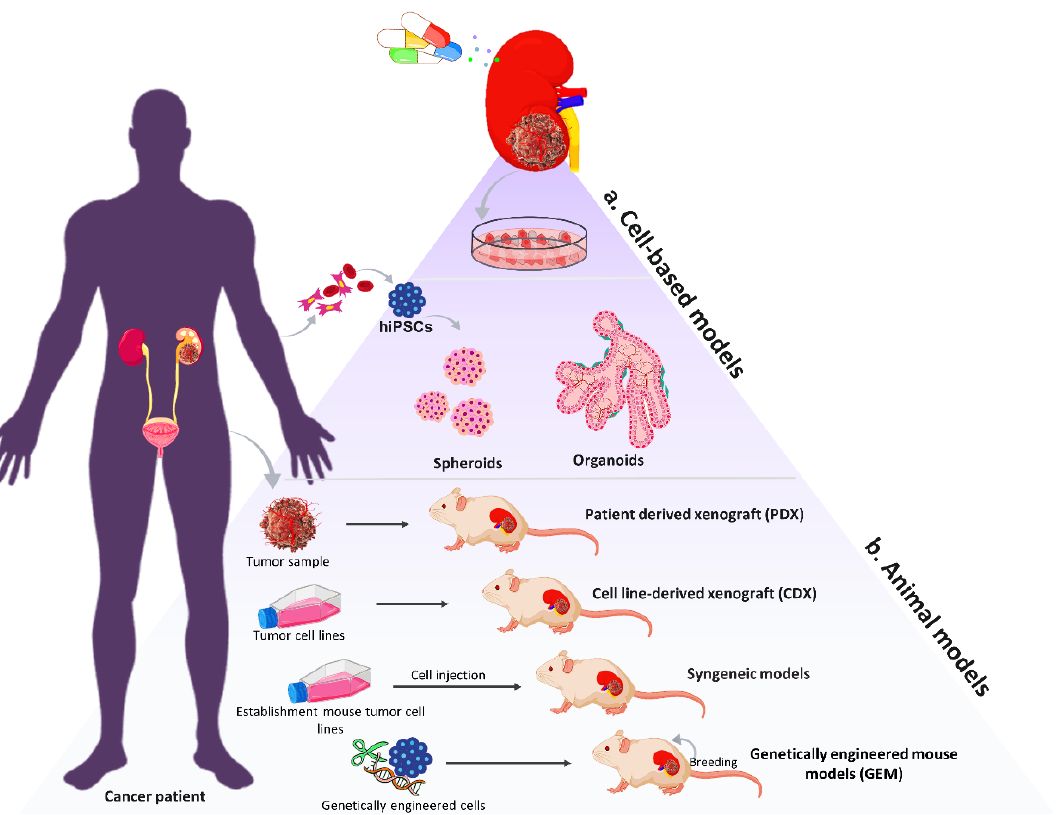
Figure 1. Summary of the various types of in vitro ( a ) and mouse models ( b ) for studying nccRCC.